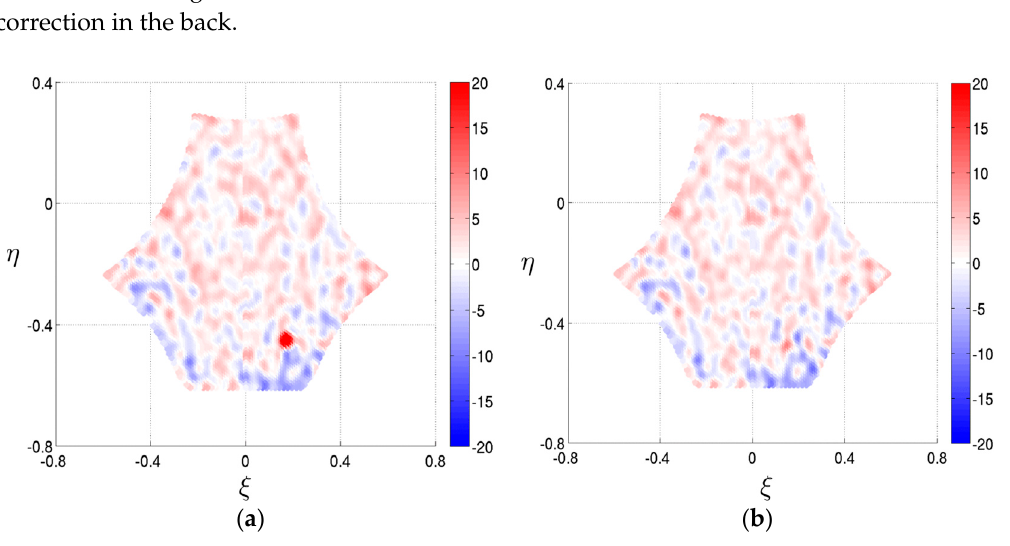
Figure 13. Time standard deviation of 100 snapshots over the ocean, with the Sun alias present at approximately [0.4, –0.15], with the old Sun correction ( a ) and the super-sampled correction ( b ).